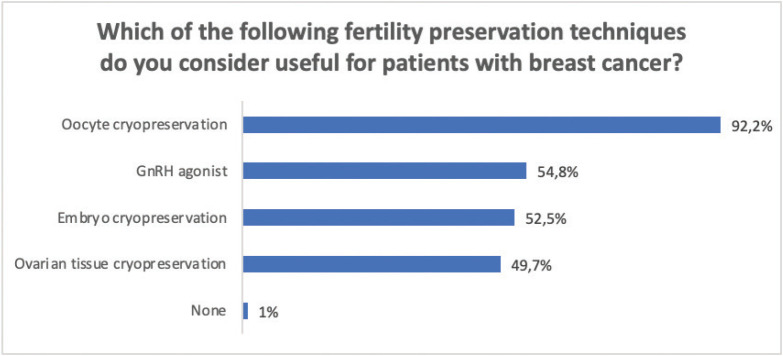
Knowledge regarding utility of different techniques of fertility preservation in patients with BC. BC = Breast cancer; CT = chemotherapy.